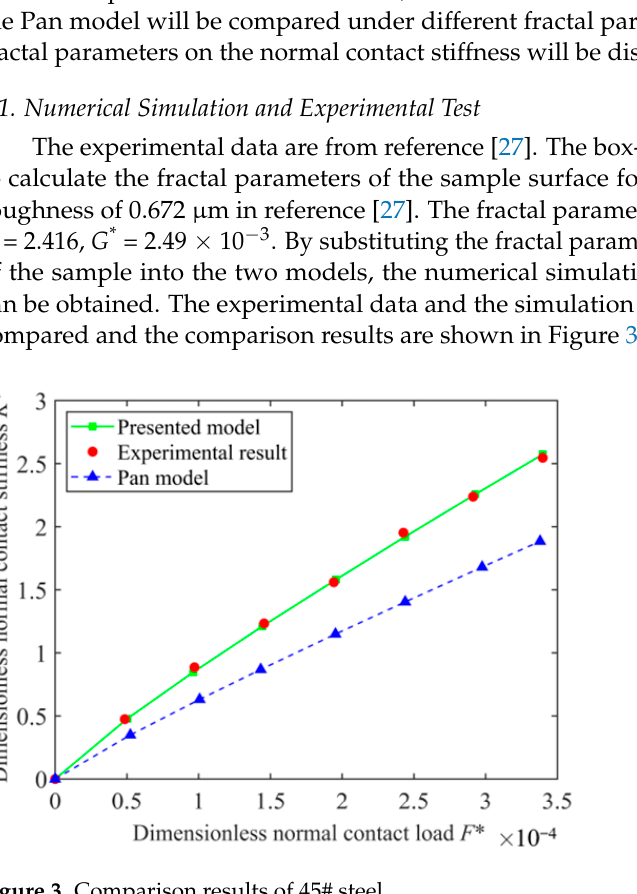
Figure 3. Comparison results of 45# steel.